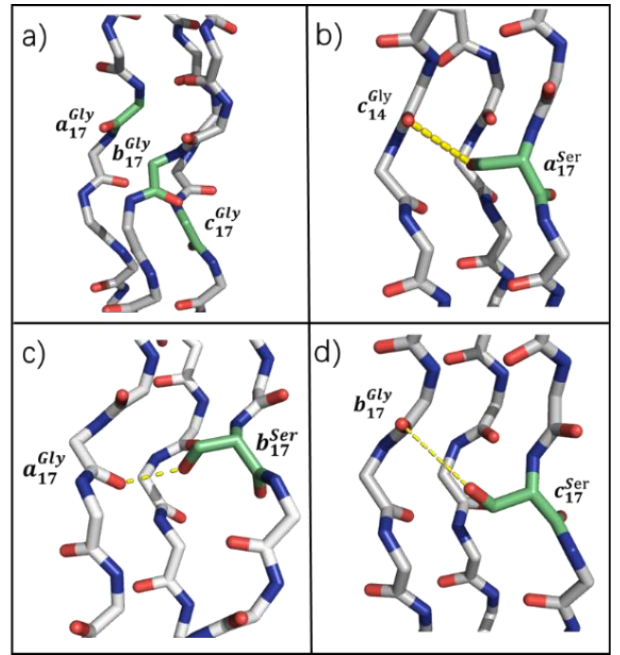
Figure 7. Snapshots of a section of the simulated collagen-like peptide triple-helix show the new direction of the H-bond compared to the original abc . The H-bond was formed between the Ser O-H and the Gly O on the adjacent chain, shown with a yellow dash. ( a ) No compensatory H- bonds in abc ; ( b ) Compensatory H-bonds in a17S formed between 17th Gly in chain a and Ser in chain a ; ( c ) Compensatory H-bonds in b17S formed between 14th Gly in chain c and Ser in chain b ; ( d ) Compensatory H-bonds in c17S formed between 17th Gly in chain b and Ser in chain c .